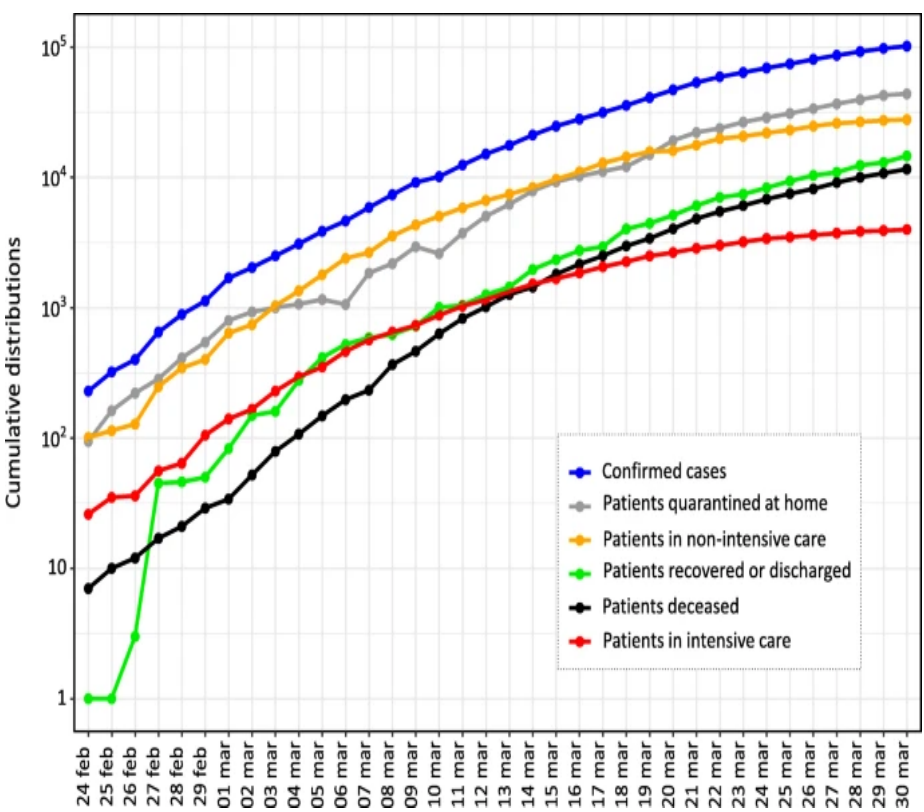
Figure 8. COVID-19 data in Italy for the first month (Megna 2020).